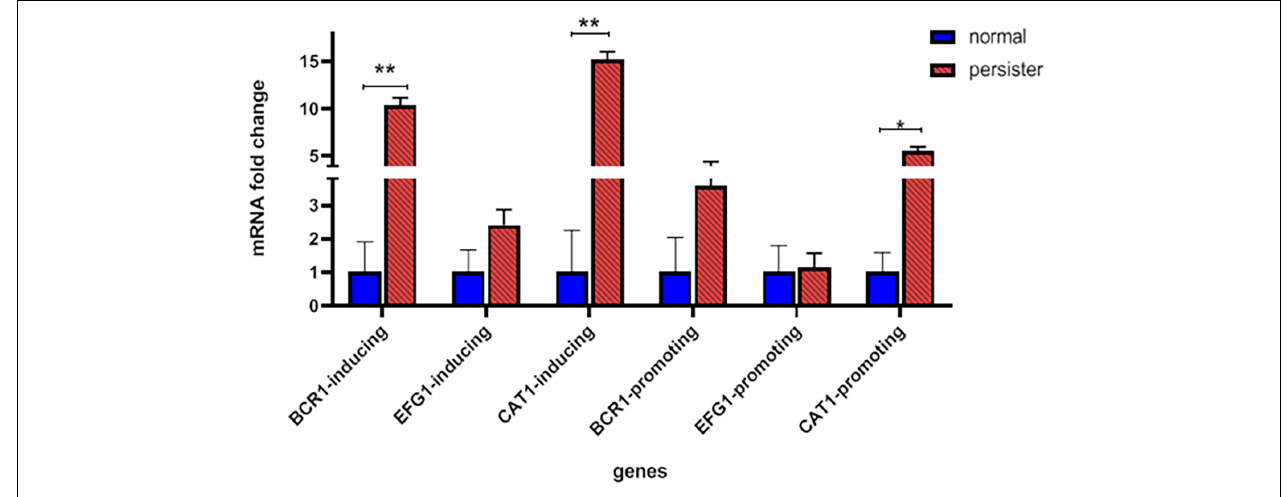
FIGURE 5 | Fold change of 2 − (cid:49)(cid:49) CT related to CAT1, BCR1 , and EFG1 genes in persister and non-persister isolates in inducing and promoting conditions ( t -test, * p -value < 0.05, ** p -value <